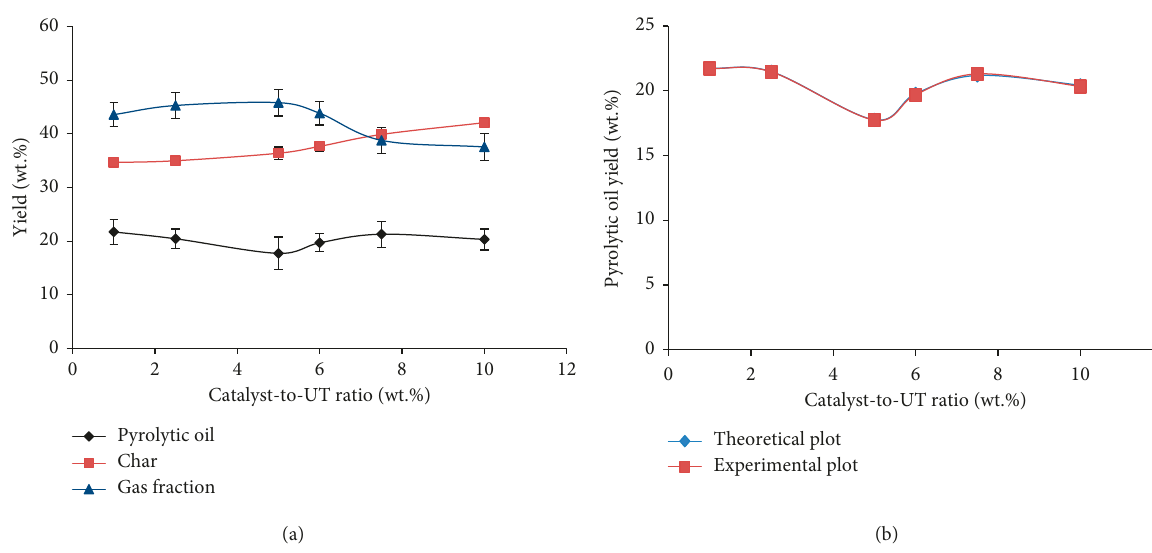
Figure 3: (a) Catalyst concentration effect on UTpyrolysis at 600 ° C (STD: pyrolytic oil � 1.41, char � 2.91, and gas � 3.46). (b) Experimental and theoretical plot of the catalyst effect on UT pyrolytic oil